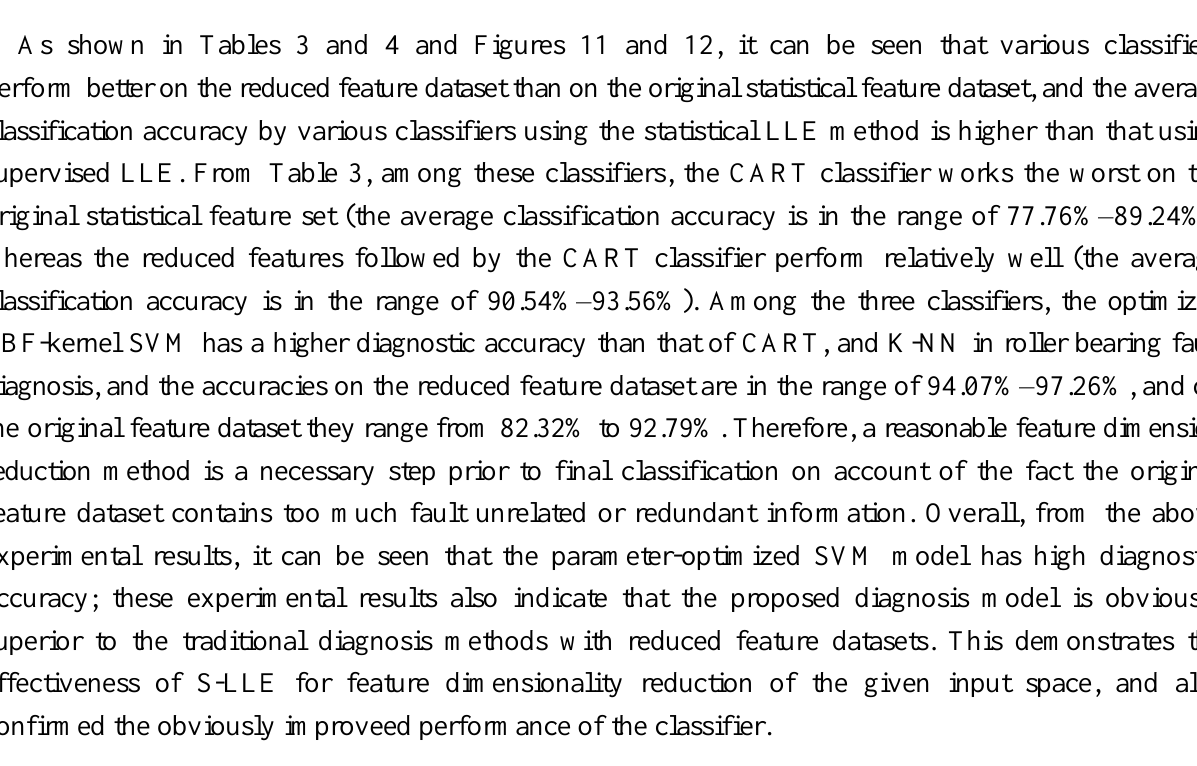
Figure 12. The comparison of the average classification accuracy with different features dataset on classifiers using supervised